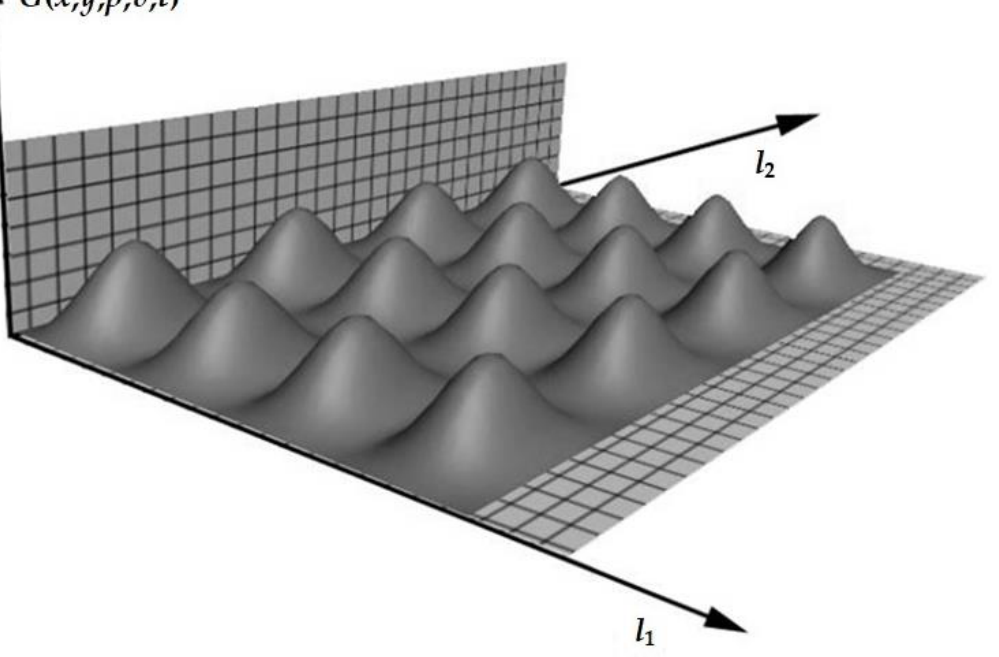
Figure 2. First heating pulse (the temperature and scale of the object are indicated in conventional units).